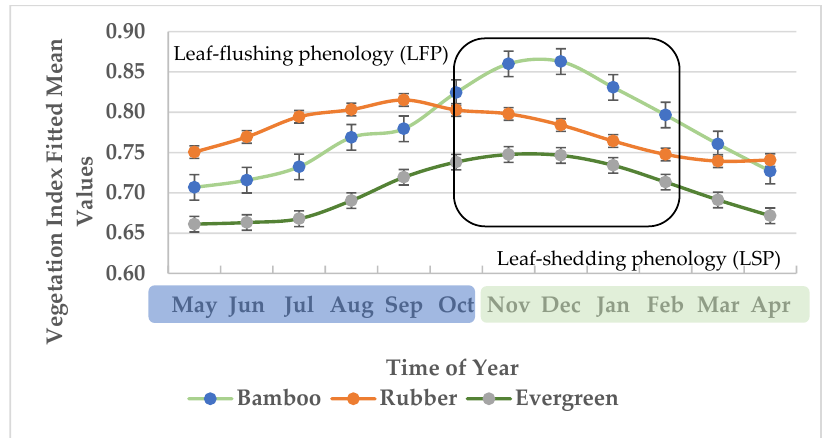
Figure 9. Time-series average index values of bamboo, rubber, and evergreen forest categories during the middle LSP season from 2015 to 2018. The average phenology index values were generated by validating 120 index profiles. The box surrounding the profiles indicates the phase of separation of the EVI profile of the three vegetation categories during the middle-leaf-shedding phenology season. Locally, May–October is the rainy season (LFP stage), and November–April is the dry season (LSP stage).